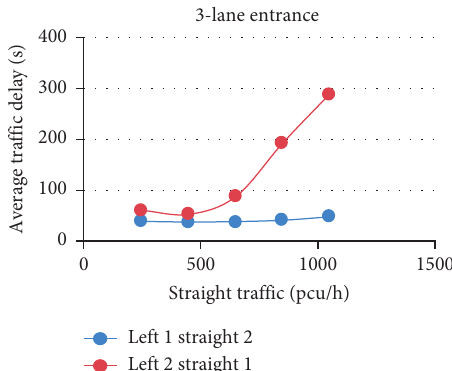
Figure 7: Change chart of the straight direction delay under different combinations of lanes on three entrance lanes.